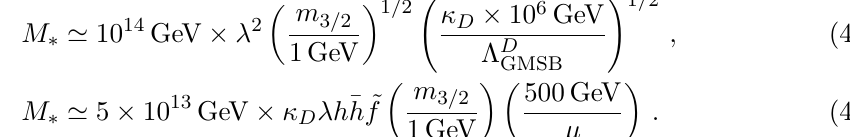
Here, the coupling constants, λ , h and ¯ h defined in the appendix A are taken real-positive without loss of generality. The coefficient functions ˜ f and ˜ g are given in eqs. (A.4) and (A.6) (see also figure 7). Note that the ratio, ˜ g 1 / 2 / | ˜ f | , is of O (1) for a wide range of